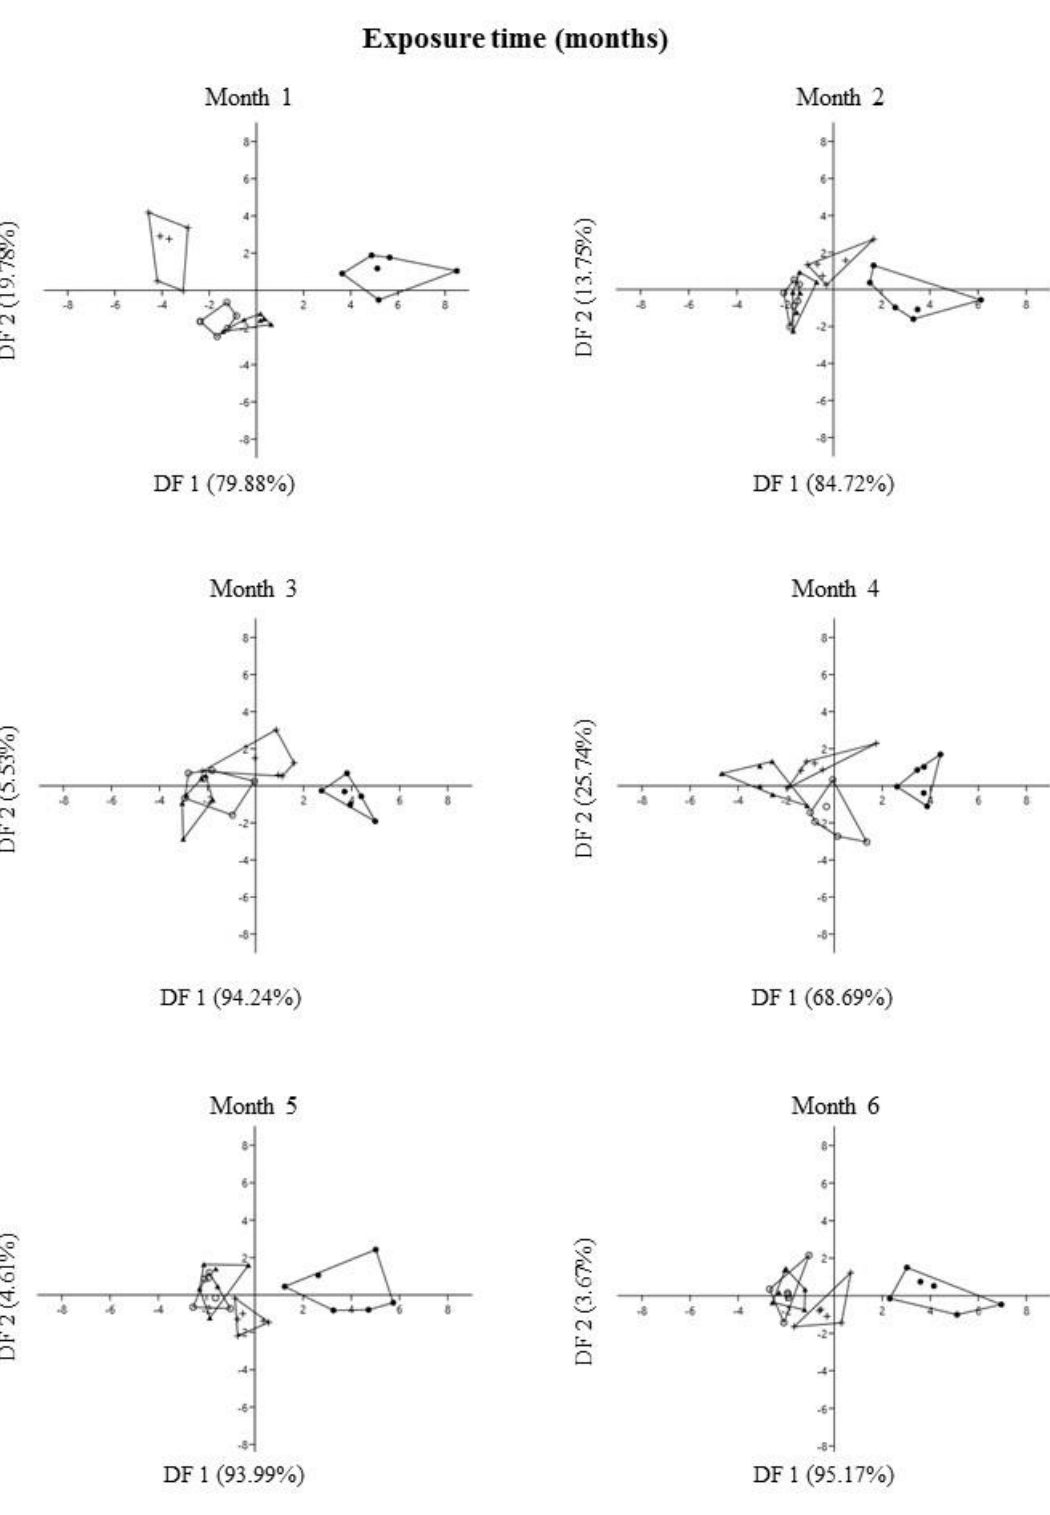
Figure 8. Plot of DF1 vs. DF2 extracted through Discriminant Function Analysis of each size character of Prosopis laevigata under greenhouse conditions. Each point is a two-dimensional (axis 1 and axis 2) representation of size character ordination. Treatments: control with fungi ( • ), control without fungi (+), tailing with fungi ( ○ ), tailing without fungi ( ▲ ). In general, DFA explained 98.30 ± 1.98 (mean ± s.d.) of the variation of the total data from DF1 and DF2 for size characters during six months of exposure (supplementary